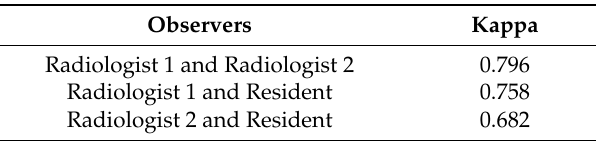
Table 5. Inter-observer agreement in the diagnosis of lesions in elastography imaging using the computer-aided diagnosis (CAD) system with different